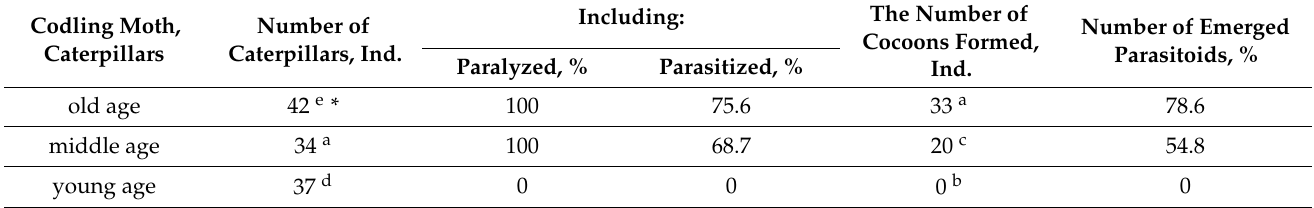
Table 2. Parasitic activity of the ectoparasitoid H. hebetor against the codling moth C. pomonella